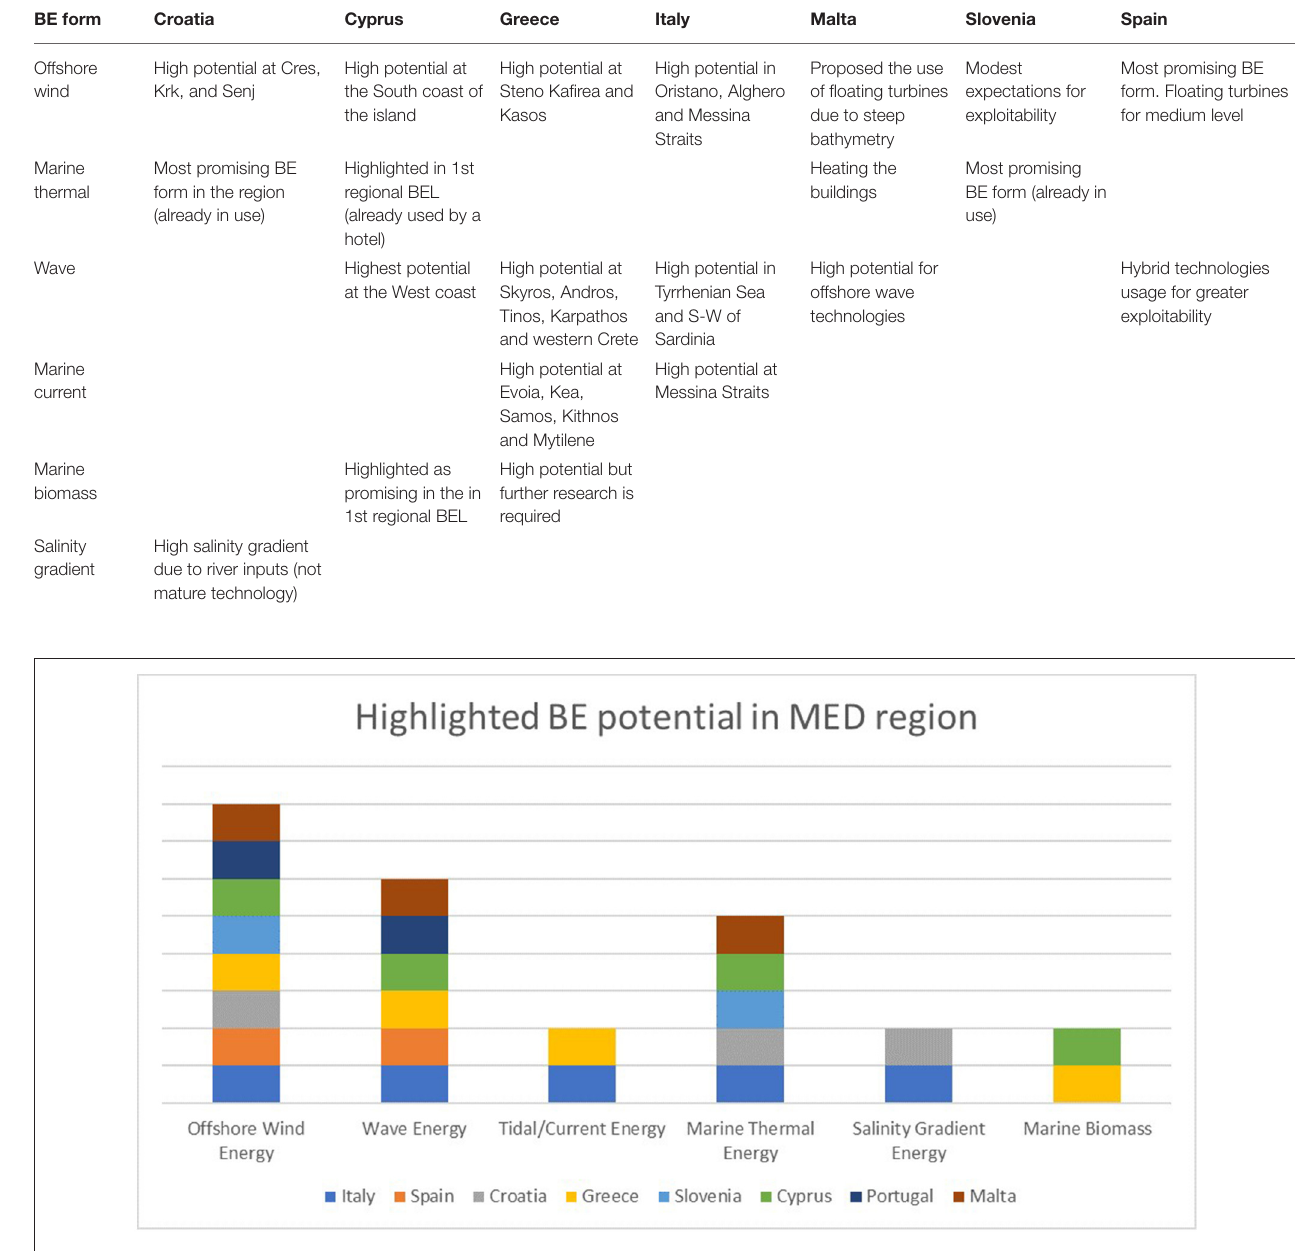
cooling or heating buildings; and (vi) marine current